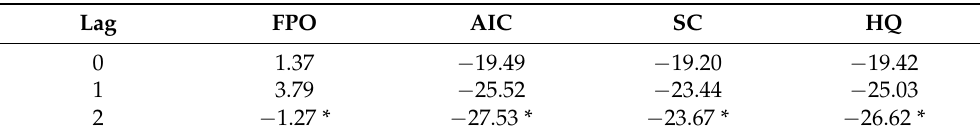
Table A2. Optimal lag selection